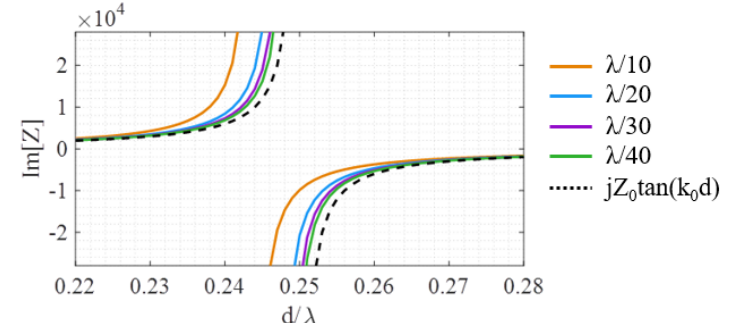
Figure 3. The imaginary part of the homogenized effective impedance of the surface when loaded with corrugations of given periodicities. As the period decreases from λ /10 to λ /40, the result approaches the analytic model, but the error remains non-negligible near resonance. The width of the groove is half of the